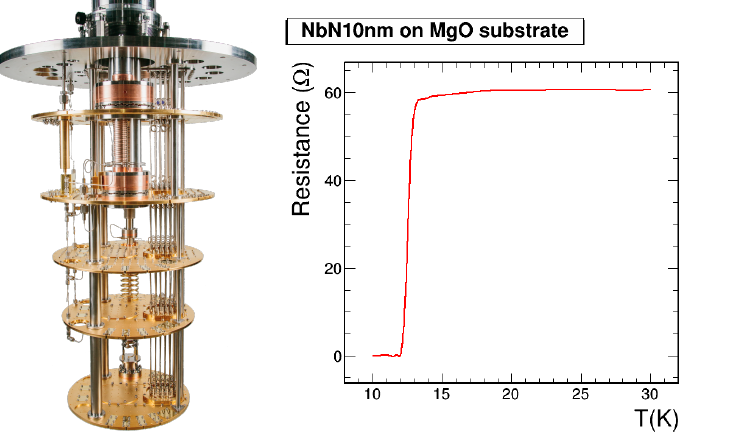
Figure 15. Triton 500 Cryogenics setup by the NTU-CCMS group ( left ). Resistance versus temperature measurement of a NbN film sample grown on MgO substrate ( right